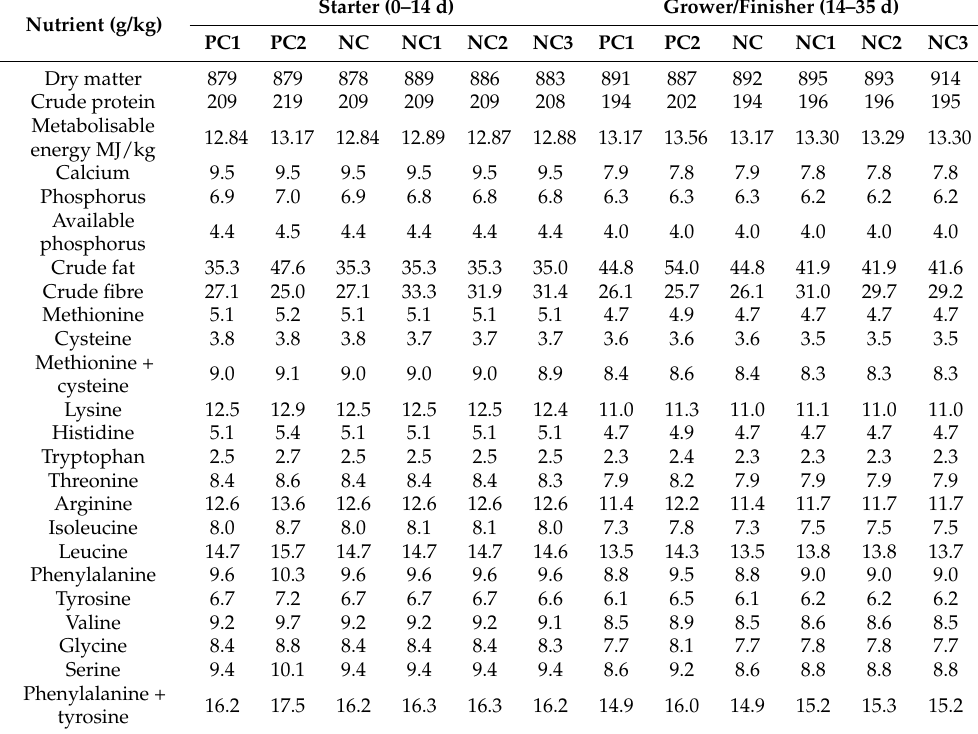
Table 2. Formulated analysis of the treatment diets (digestible amino acids) (fresh